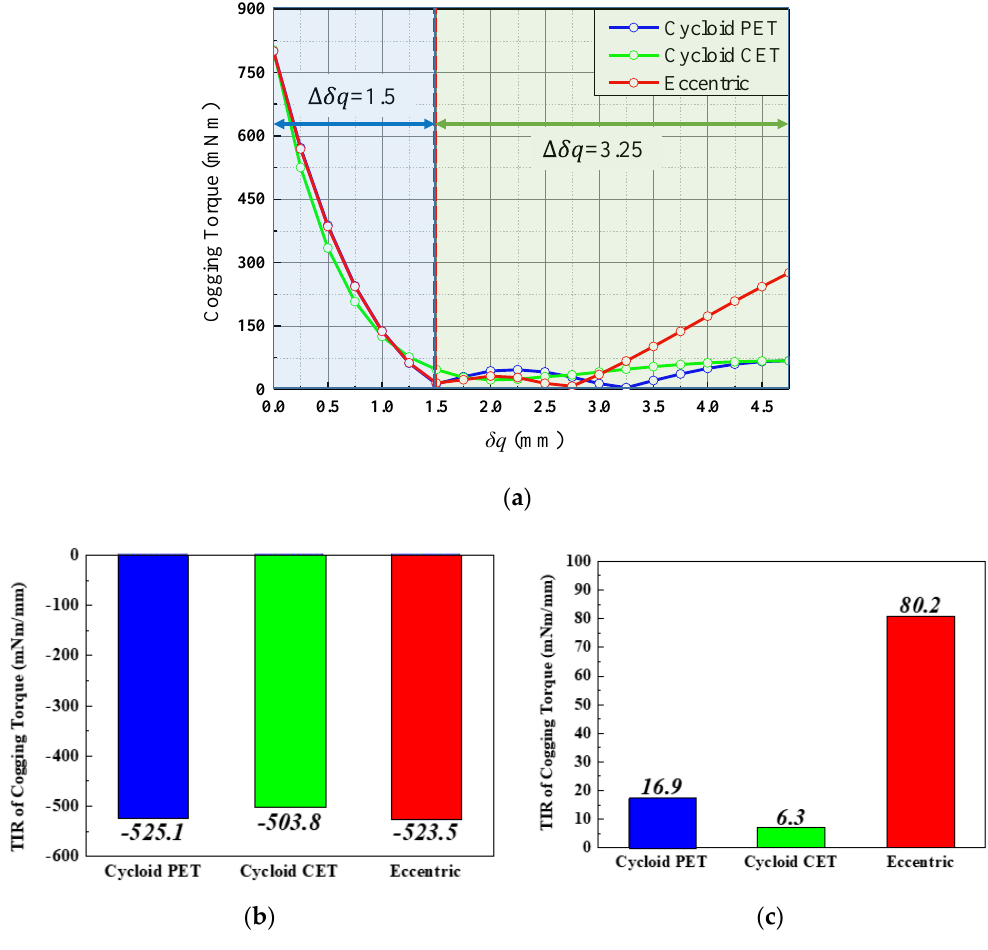
Figure 8. Cogging torque according to δ q of each curve: ( a ) trend in cogging torque according to δ q ;